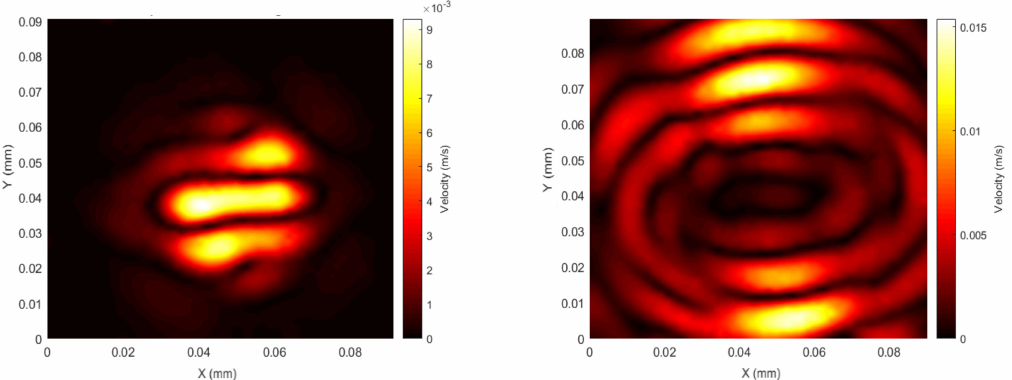
Figure 12. Configuration 4—patch spatial scan at the beginning of the first peak of the signal ( left , t = 14 µ s) and the end of the pulsed wave ( right , t = 22 µ s); f = 120 kHz, 1 cycle sine wave.